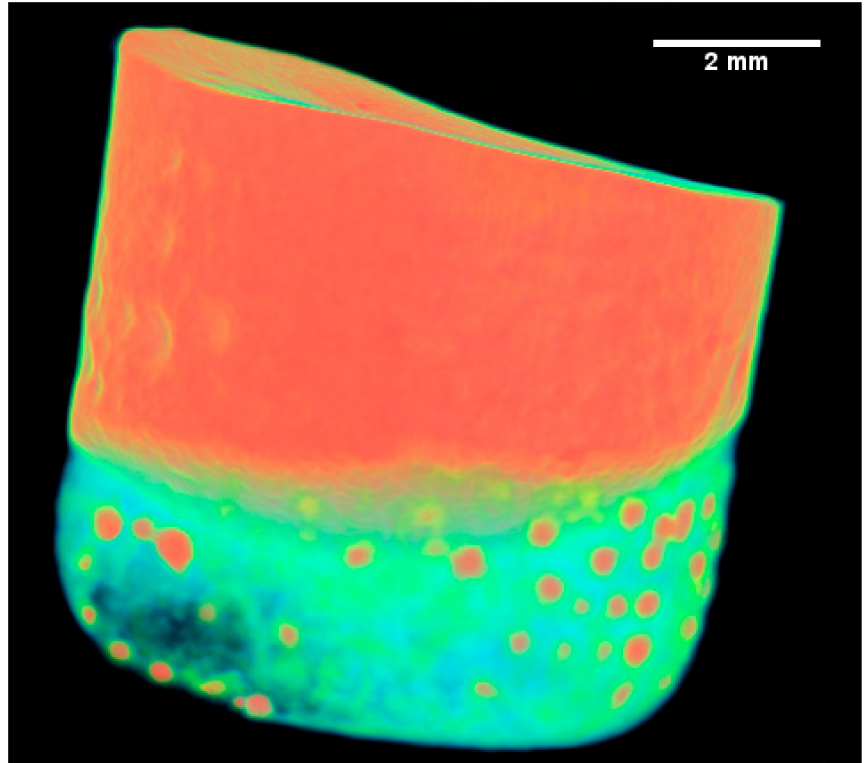
Figure 10. Reconstructed computed tomography of the CoCrCu system with void present in the bottom left, and CoCr-rich (red) globules dispersed throughout Cu-rich (green)